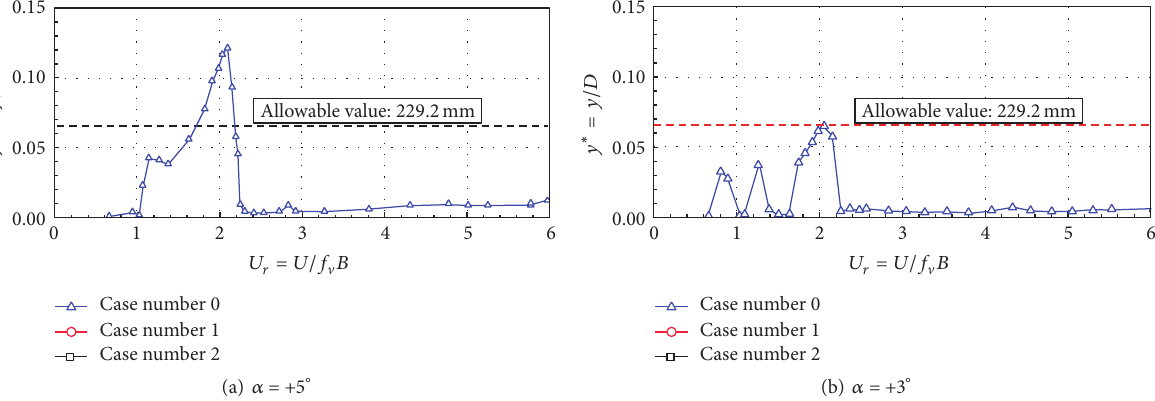
Figure 3: RMS of vertical displacement of Case #0 .